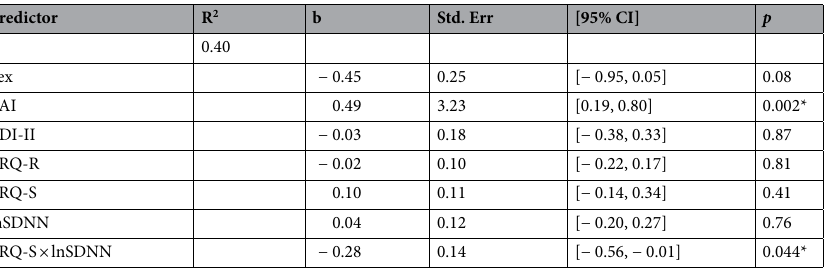
Table 3. Linear regression model testing the main effects of pre-pandemic expressive suppression, HRV, their interaction, and pre-pandemic reappraisal, anxiety, and depressive symptoms as covariates. BAI Beck Anxiety Inventory, BDI-II Beck Depression Inventory, ERQ-R Emotion Regulation Questionnaire-Reappraisal scale, ERQ-S Emotion Regulation Questionnaire-Expressive Suppression scale, lnSDNN natural logarithm of standard deviations of N–N intervals. * p < 0.05.